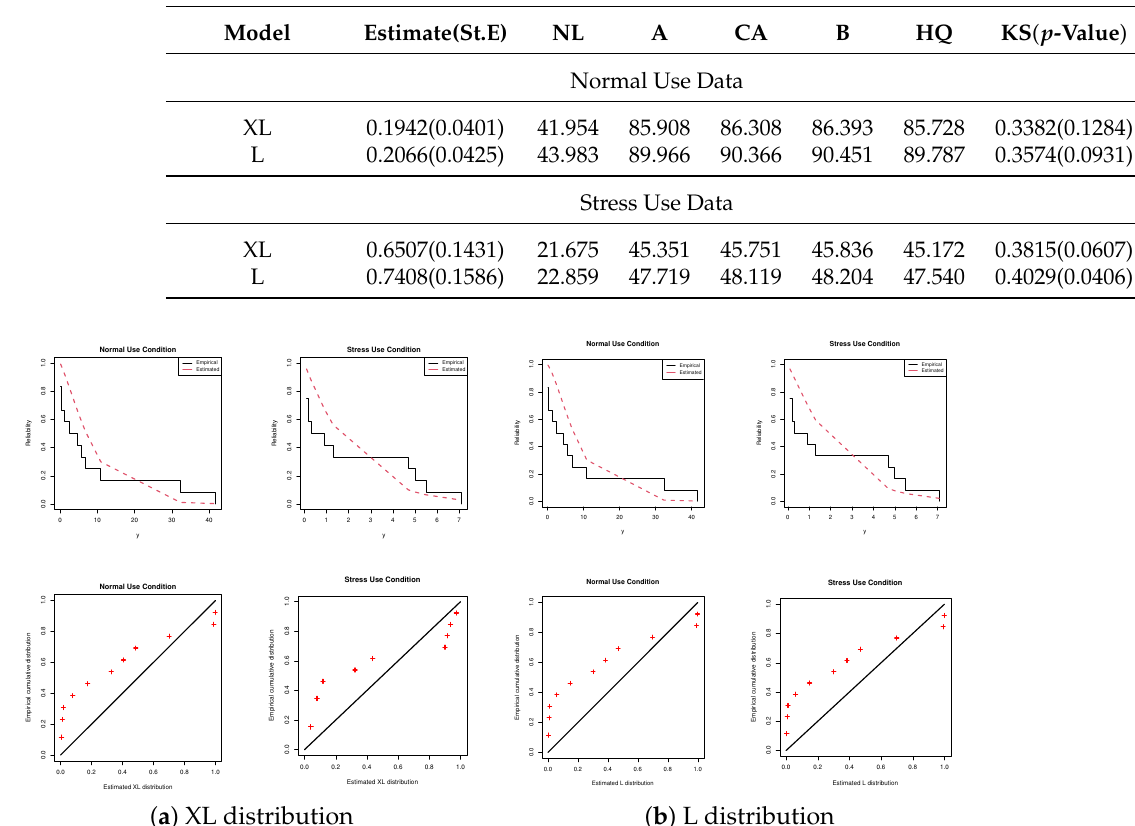
Table 2. Summary fit of the XL and L distributions from insulating fluid data.